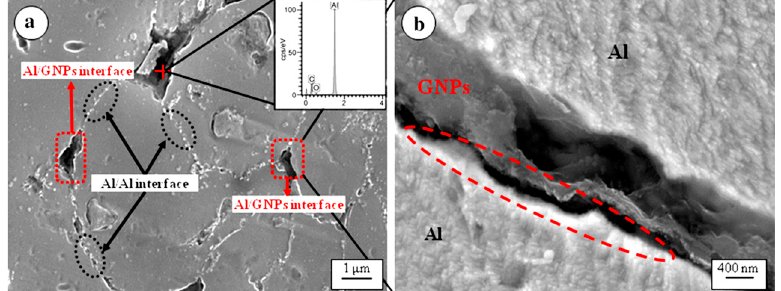
Figure 10. SEM micrograph of ( a ) hot-rolled Al-1.0 wt % GNPs, ( b ) magnification of an Al/GNPs interface [131], Reproduced from [131], with permission from Springer Nature, 2017.